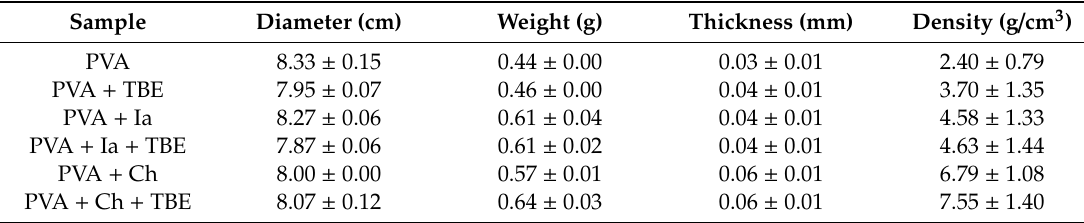
Table 5. The physical measurements of the solid PVA-based films; the shown data represent the mean value of three replicates with the standard deviation ( ± ).